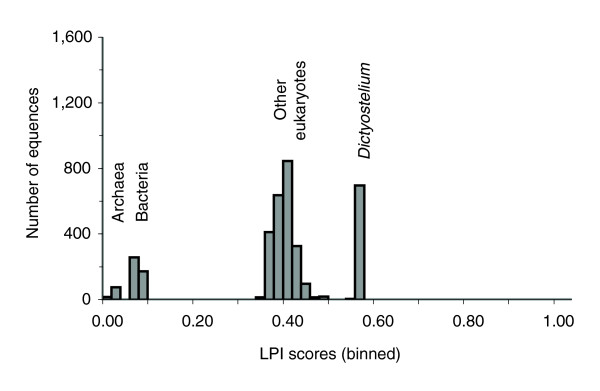
LPI score distribution histogram for E. histolytica. Filter threshold setting was zero.